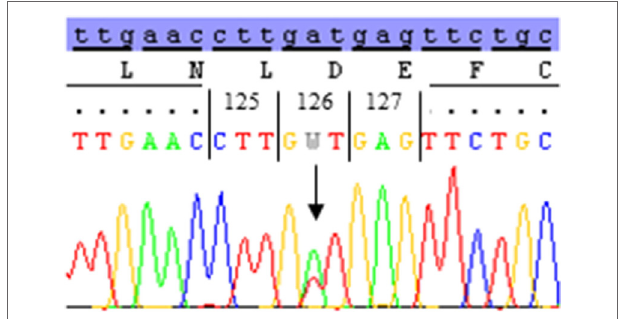
FigUre 1 | The DNA sequence of codon 123–129 of the calcium-sensing receptor ( CASR ) gene in the affected family members. The DNA sequence analysis of exon 3 reveal a nucleotide substitution of adenine (A) to thymidine (T) in codon 126 of the CASR gene; subsequently changing the amino acid aspartic acid (D) (GAT) to valine (V) (GTT). The heterozygous A/T mutant sequence of codon 126 was identified in I-2, II-2, and II-3.